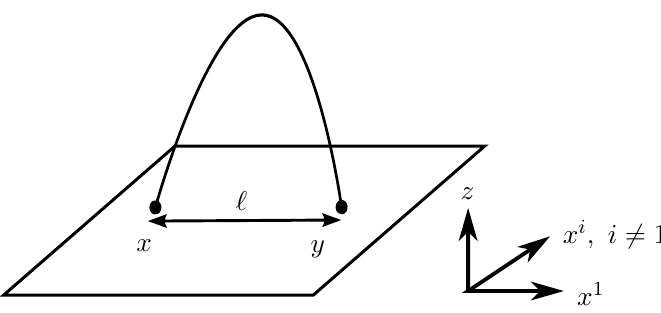
Figure 3. Calculation of the two-point function from a geodesic in AdS